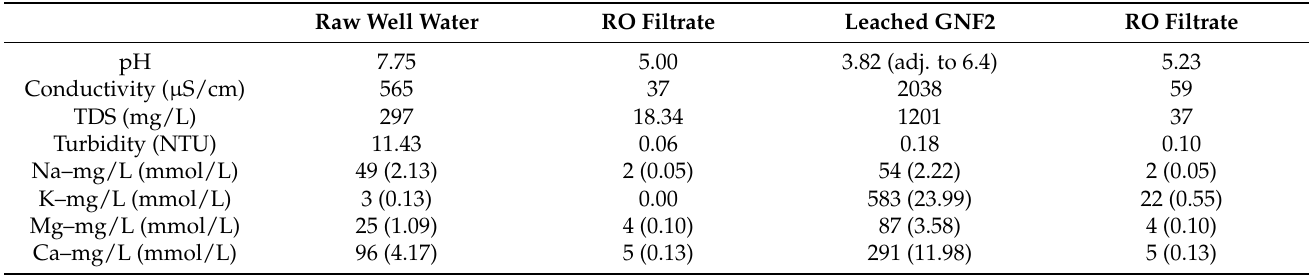
Table 8. Raw and treated well water results compared with treated and leached